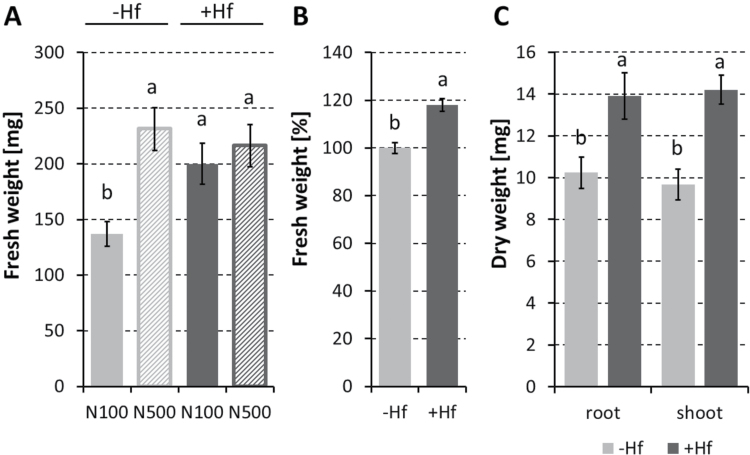
Growth promotion of M. sinensis by H. frisingense GSF30T (Hf). The graphs show total biomass from 6-week-old plants. (A) Fresh weight [mg, ±standard error (SE)] of seedlings grown with (+Hf, dark grey bars) or without H. frisingense (–Hf, pale grey bars) under low (N100, 50 µM NH4NO3; 12 plants) or higher (N500, 250 µM NH4NO3; 13 plants) nitrogen levels. Different lower-case letters indicate a significant difference by ANOVA test (P < 0.05). (B) Fresh weight (% compared with –Hf, ±SE) following H. frisingense inoculation (n=11 independent experiments; total 223 plants +Hf and 259 plants –Hf) under N100 conditions. Different lower-case letters indicate a significant difference by ANOVA test (P < 0.001). (C) Dry weight (mg, ±SE) of 6-week-old seedlings, separated for roots and shoots, without or with H. frisingense inoculation under N100 conditions.